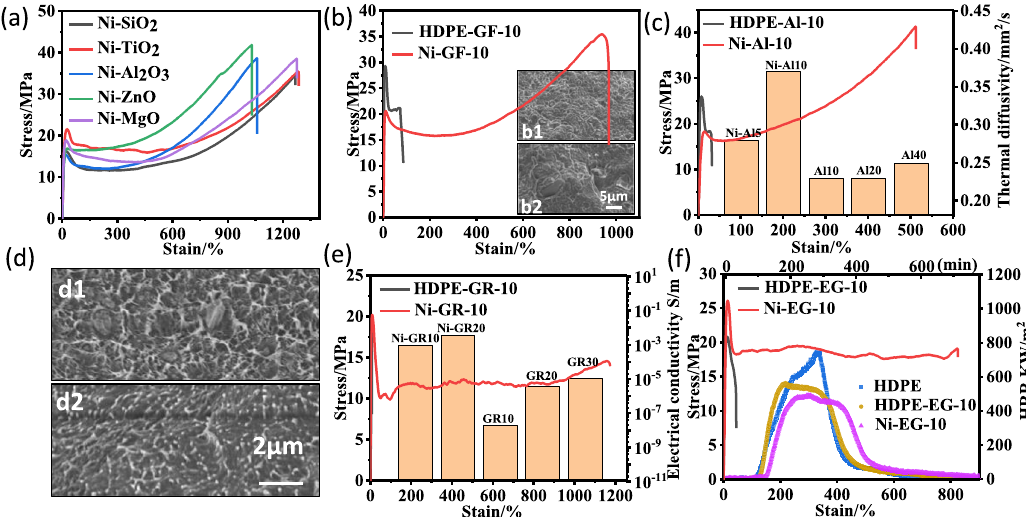
Fig. 5 Properties of polyethylene composites. The number in the sample name represents the approximate content of inorganic fi ller; the sample names containing “ Ni ” were prepared from in situ polymerization using supported catalysts, and the other samples were prepared from extrusion blending; GF, Al, GR and EG represent Glass fi ber, Al 2 O 3 , Graphene and Expanded graphite, respectively. a Stress-strain curves of samples obtained using Ni-SiO 2 (Table 1, Entry 6), Ni-TiO 2 (Table 1, Entry 7), Ni-Al 2 O 3 (Table 1, Entry 8), Ni-ZnO (Table 1, Entry 9), and Ni-MgO (Table 1, Entry 10). b Stress-strain curves of HDPE- GF-10 and Ni-GF-10. Inset: SEM images (b1 and b2) of Ni-GF-10 and HDPE-GF-10. c Stress-strain curves of HDPE-Al-10 and Ni-Al-10. The thermal diffusivity of Ni-Al5, Ni-Al10, Al10, Al20, and Al30. d SEM images (d1 and d2) of Al20 and Ni-Al20. e Stress-strain curves of HDPE-GR-10 and Ni-GR-10. Inset: the electrical conductivity of Ni-GR10, Ni-GR20, GR10, GR20, and GR30. f Stress-strain curves of HDPE-EG-10 and Ni-EG-10. Inset: the heat release rates of HDPE, HDPE-EG-10, and